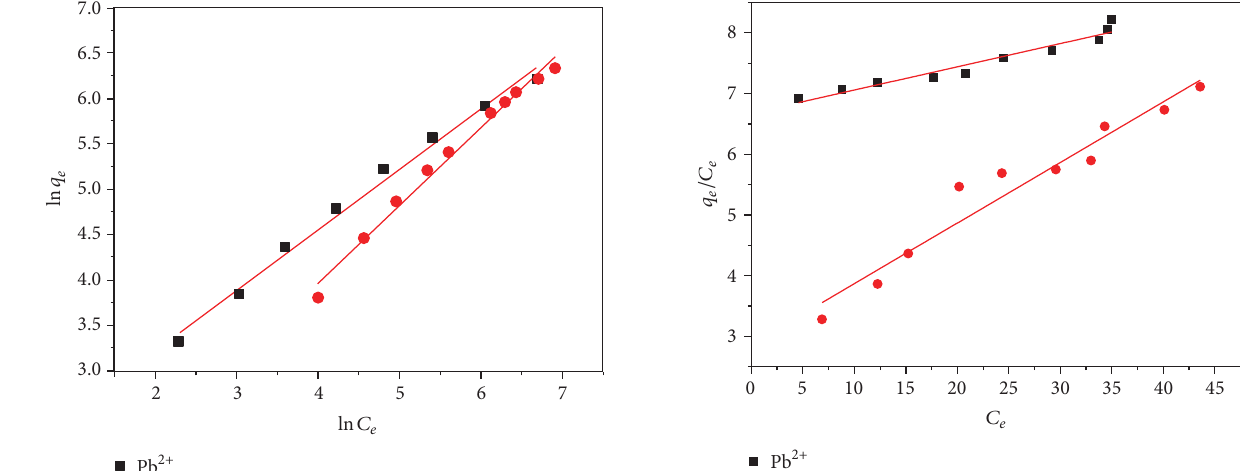
Table 3: Isotherms constants and correlation coefficients for the adsorption of Pb 2+ and Cd 2+ on cross-linked starch xanthate.